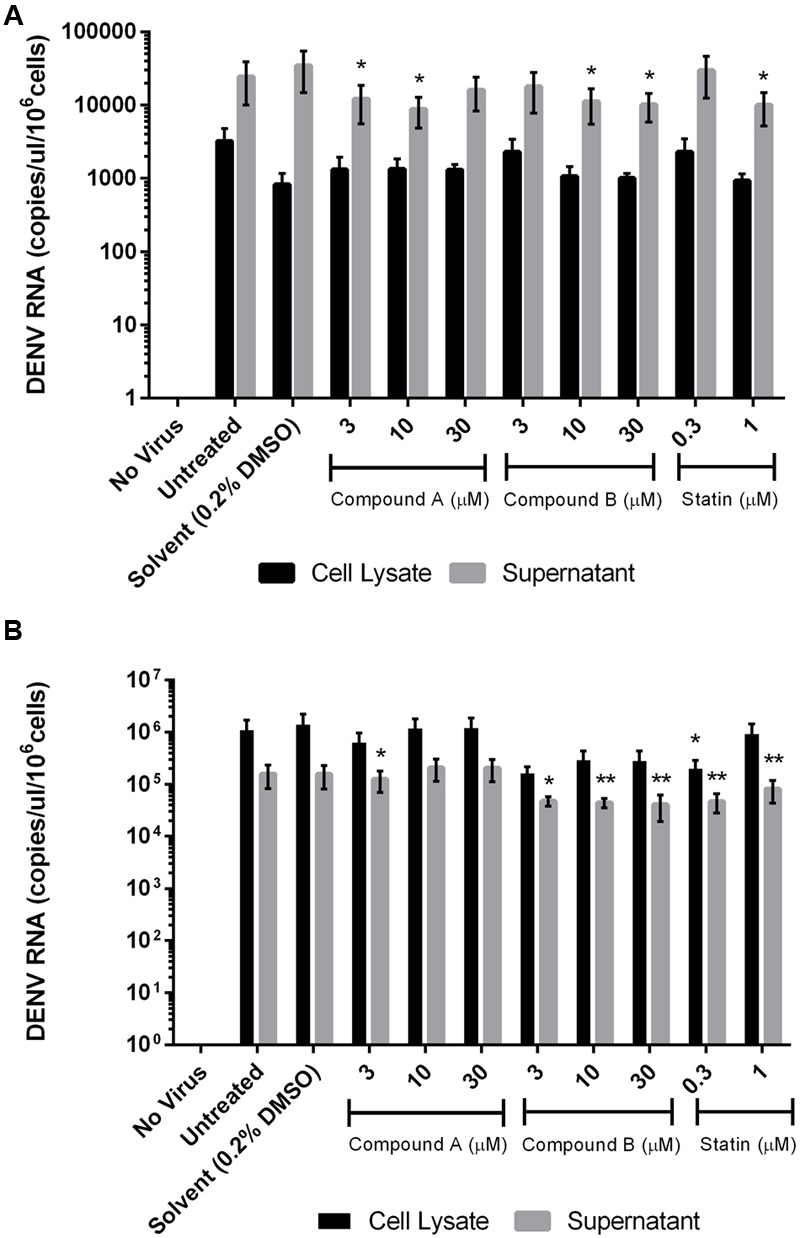
Effect of compounds A and B on DENV RNA copy number in infected cells. Uninfected and DENV-infected THP-1 (A) or 293T (B) cells were left untreated or treated with compound A or compound B (range: 3–30 μM), or statin (range: 0.3–1 μM) for 72 h. Total RNA was extracted from cell lysates and DENV RNA was detected by RT-qPCR. Results show the mean of two independent experiments. ∗P < 0.05, ∗∗P < 0.01 vs. control (0.2% DMSO; unpaired two-tailed t-test). Data represent mean ± SEM.